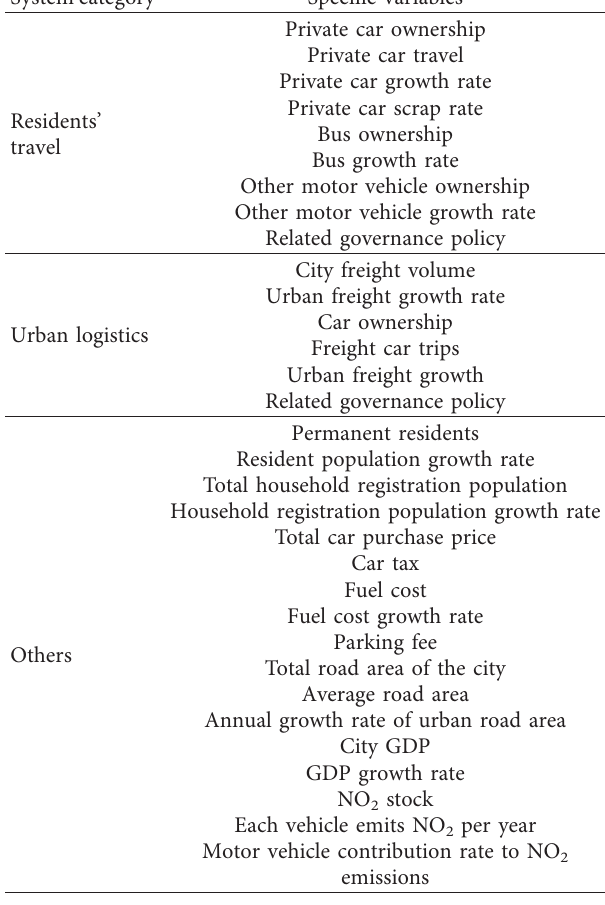
Table 1: Determination of system boundaries. System category Specific